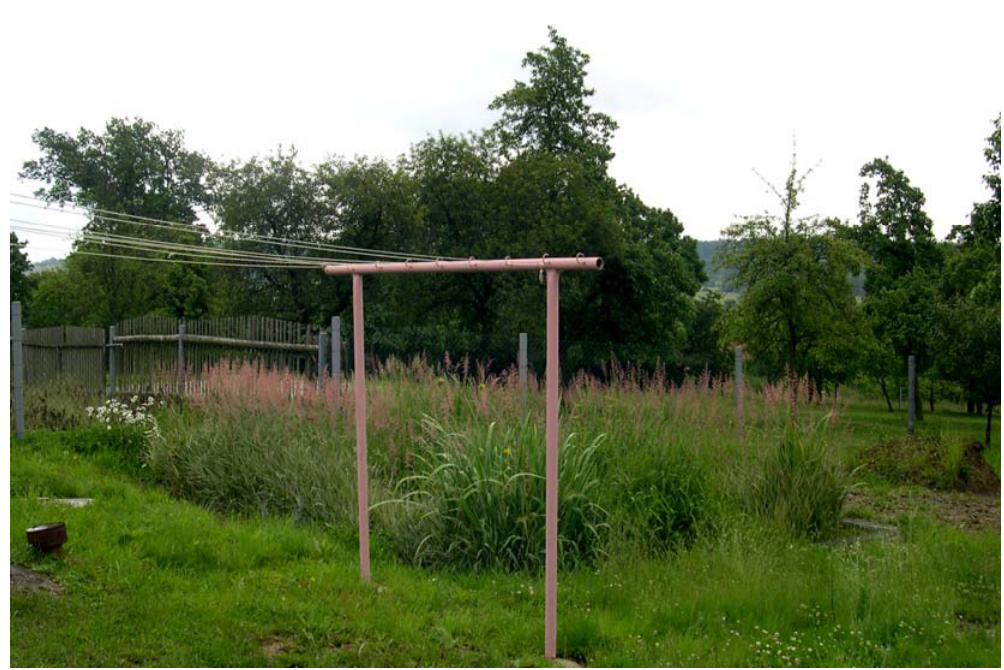
Figure 6. On-site horizontal flow (HF) CWs at Struha ř e, Czech Republic, planted with Phalaris arundinacea and Iris pseudacorus . Photograph taken by the